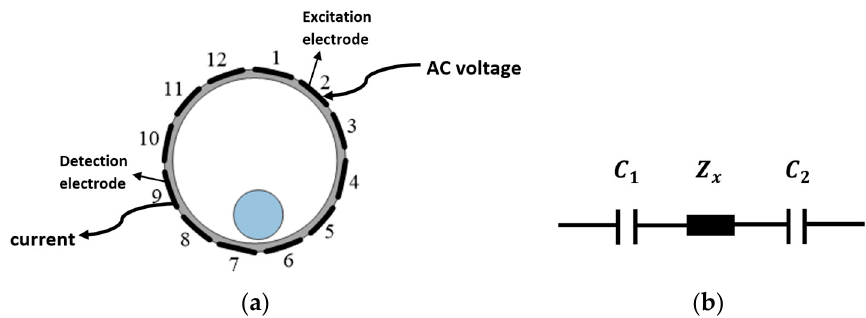
Figure 1. ( a ) Demonstration of an electrode pair. ( b ) Equivalent detection